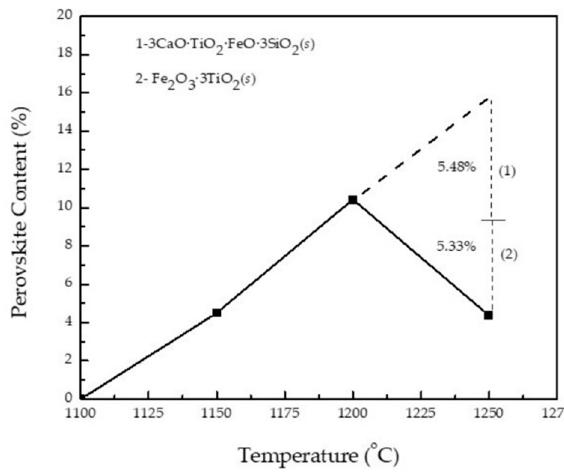
Figure 8. Quantified perovskite content from the XRD phase analyses data.